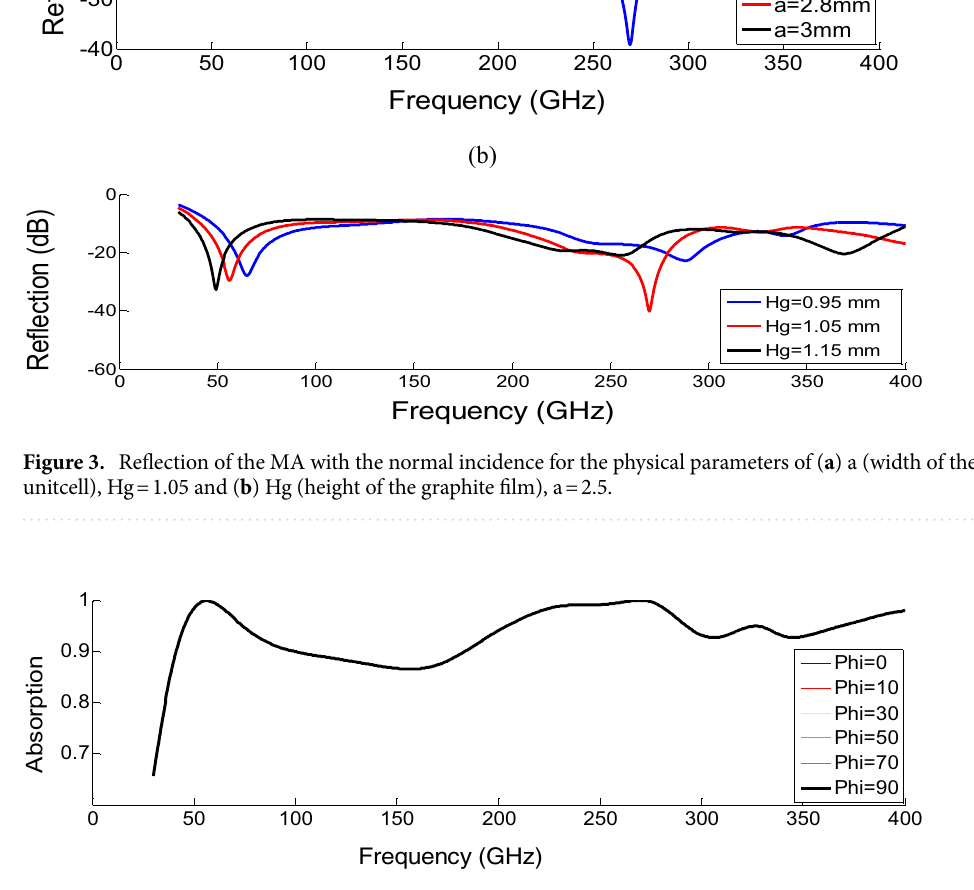
Figure 4. Absorption curves as a function of polarization angle (phi) under the normal incidence with a = 2.5 mm and Hg = 1.05